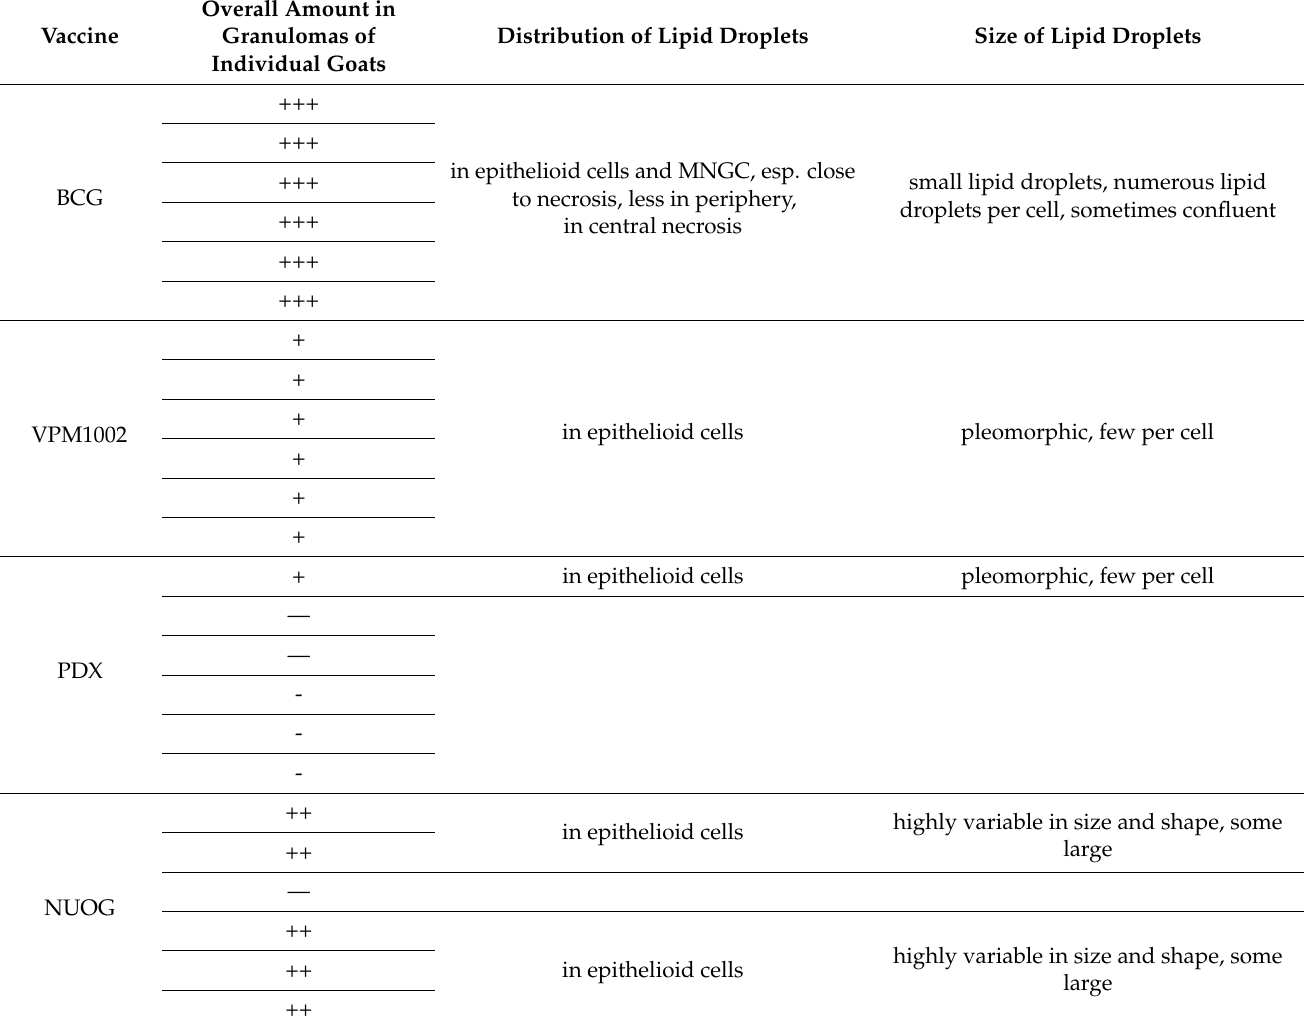
Table 2. Lipid droplets in foam cells in caseous granulomas of goats (n = 6 per vaccine group) after injection of BCG, VPM1002, PDX or NUOG.